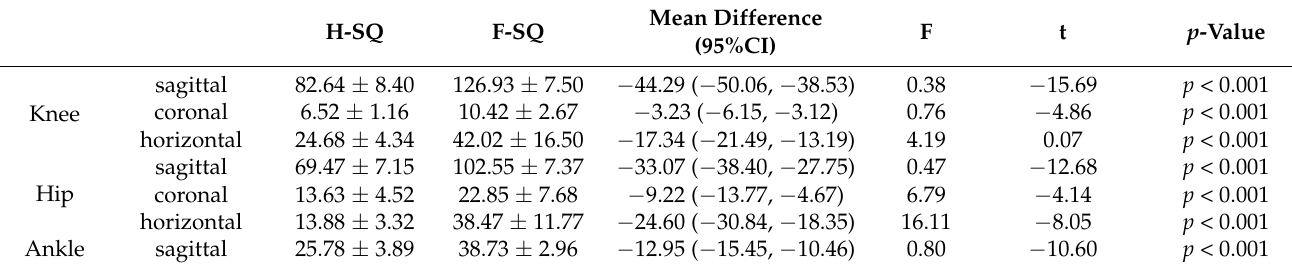
Table 1. Range of joint